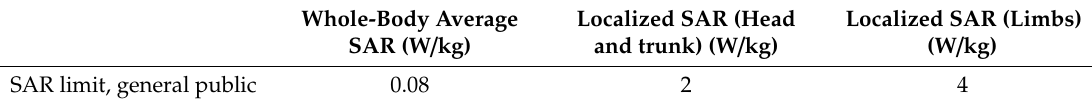
Table A1. SAR (specific absorption rate) basic